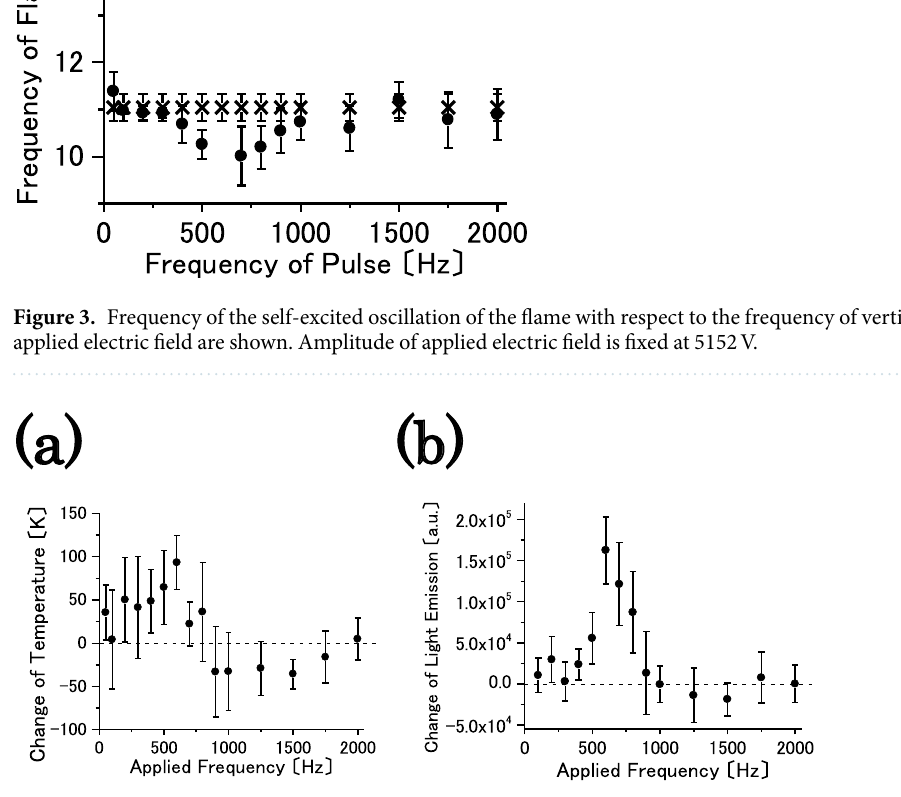
electrodes as an external force and is continuously changed. Amplitude of the applied electric field is fixed at 5152 V. Figure 3 shows the experimental results, i.e., the frequency of the self-excited oscillation of the flame with respect to the frequency of the vertically applied electric field. In the figure, the error bars represent the standard deviation, which is calculated based on seven measurements for each parameter. When the applied ac frequency